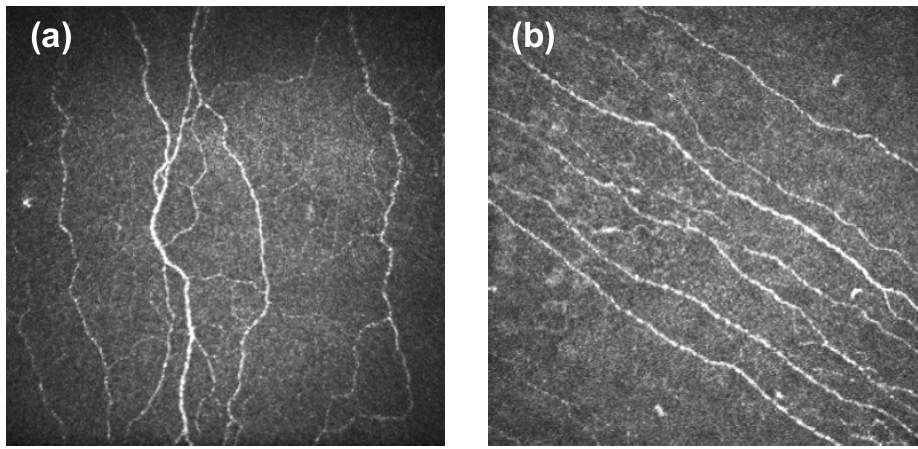
Figure 1. Cornel nerve tortuosity. ( a ) High tortuosity. ( b ) Low tortuosity. Different criteria have been used to define and measure the tortuosity of different anatomical structures such as intracerebral vasculature [30] or retinal vessel [31]. Once the anatomical structure is identified in an image, it will be represented as a group of pixels with a curvilinear shape, and then its tortuosity can be measured. Designed measurements are based on different features such as length [30,31], angle [32–34] and curvature [35], but there is no standard measure for quantifying the tortuosity of nerve fibers